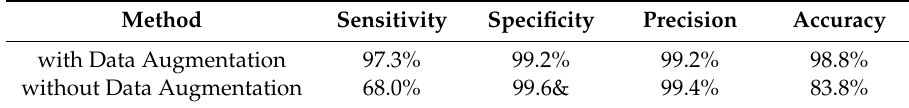
Table 2. Comparison of the classification performance between the methods with and without data augmentation.